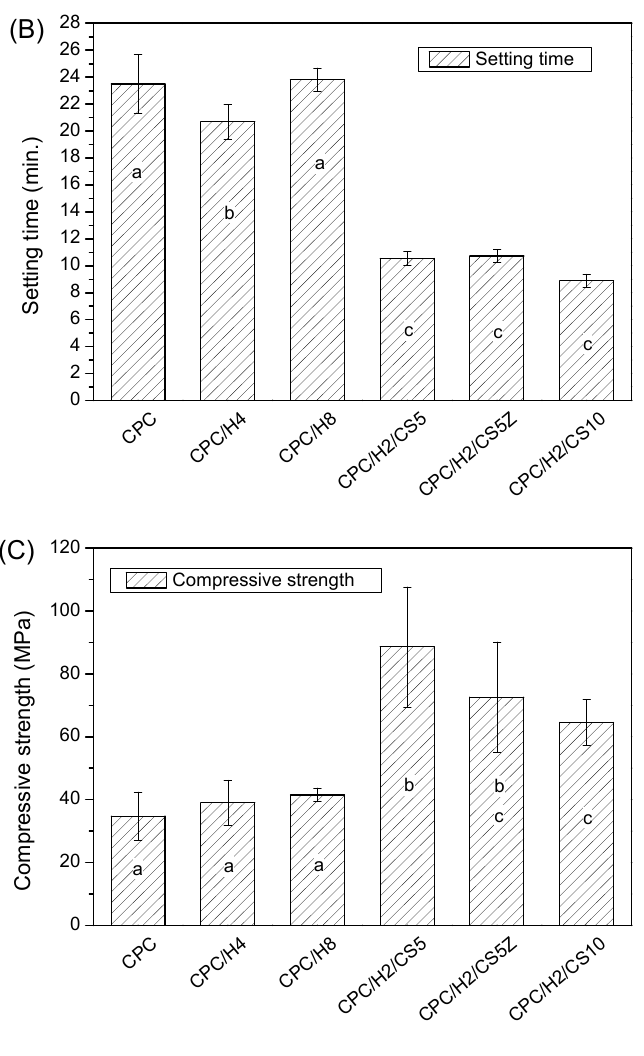
Figure 2. The working time ( A ); setting time ( B ); and compressive strength ( C ) of CPC; CPC/H4, CPC/H8, CPC/H2/CS5, CPC/H2/CS5Z, and CPC/H2/CS10. The data in the same statistical level was marked with the same letter (a, b, and c) on the bar.